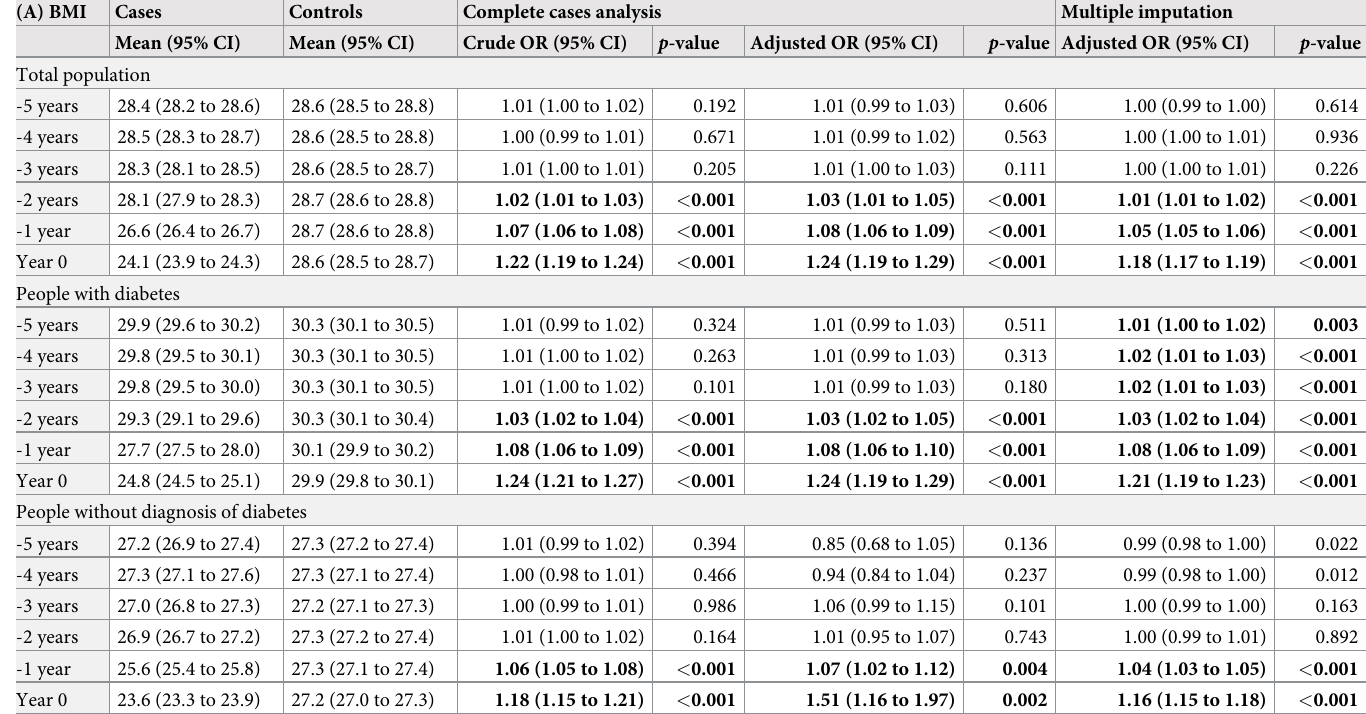
Table 2. Odds ratios (OR) and 95% confidence intervals (CI) calculated with conditional logistic regression for the association of pancreatic cancer with decrease in body mass index (BMI) i.e., weight loss over time calculated with conditional logistic regression. Subgroup analysis by diabetes. Bolded text indicates statistically sig- nificant results. Statistical significance was considered at p <